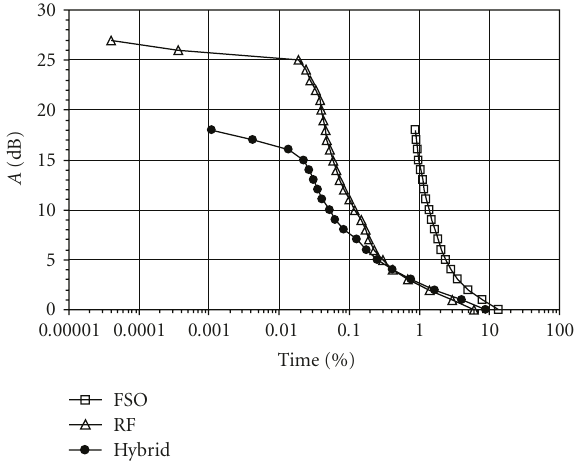
Figure 15: Obtained CDs of attenuation due to all the hydrom- eteors combined for the FSO link, RF link, and simulated hybrid FSO/RF system.